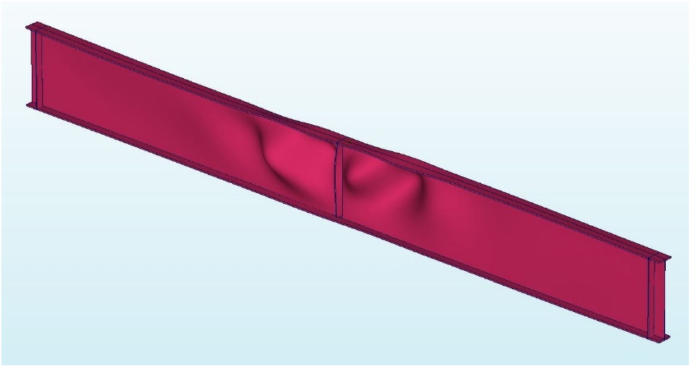
Figure A2. The 2nd buckling mode, α cr = 9.4, scale × 2, computer code